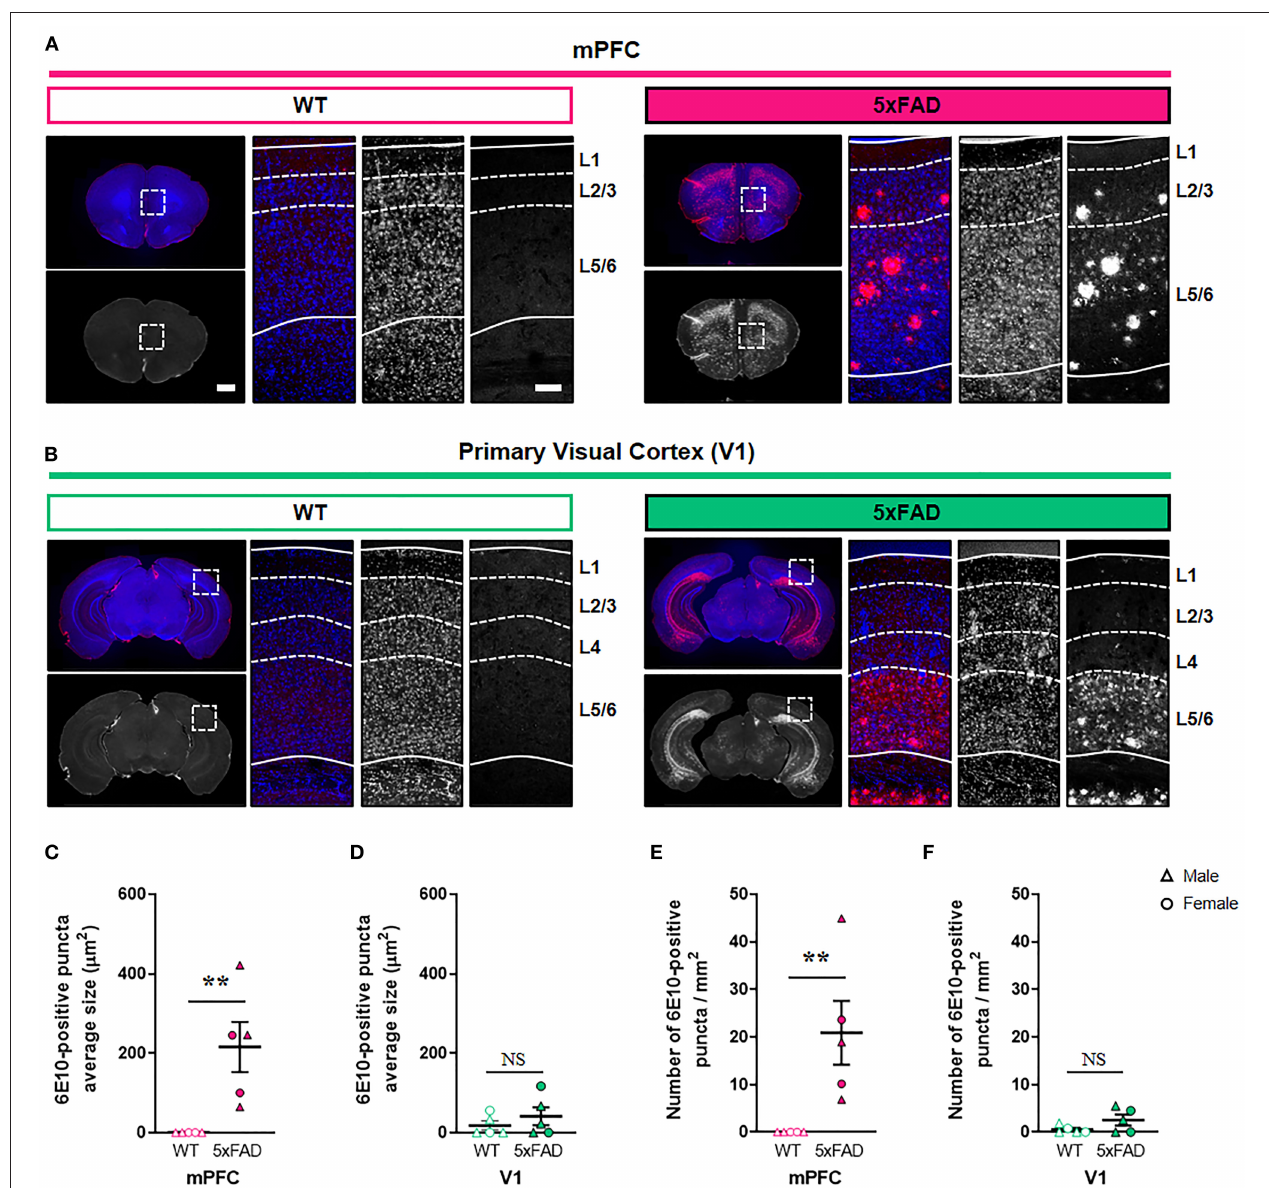
FIGURE 1 | Elevated amyloid deposition in the mPFC, but not V1, of 6-month-old 5xFAD mice. (A,B) Representative fluorescence images of amyloid plaques stained with 6E10 antibody in the mPFC and V1 of wild-type (WT) and 5xFAD mice. Dashed boxes in whole brain images indicate regions of interest. Dotted lines indicate quantified cortical layers. mPFC, medial prefrontal cortex; V1, primary visual cortex. Scale bars, 1mm (low magnification) and 100 µ m (high magnification). (C,D) Quantification of amyloid puncta size in layer 2/3 of the mPFC (C) and V1 (D), respectively (n = 5 animals per group). (E,F) Quantification of amyloid puncta density in layer 2/3 of the mPFC (E) and V1 (F) , respectively ( n = 5 animals per group). ** P < 0.01; Mann-Whitney U test.